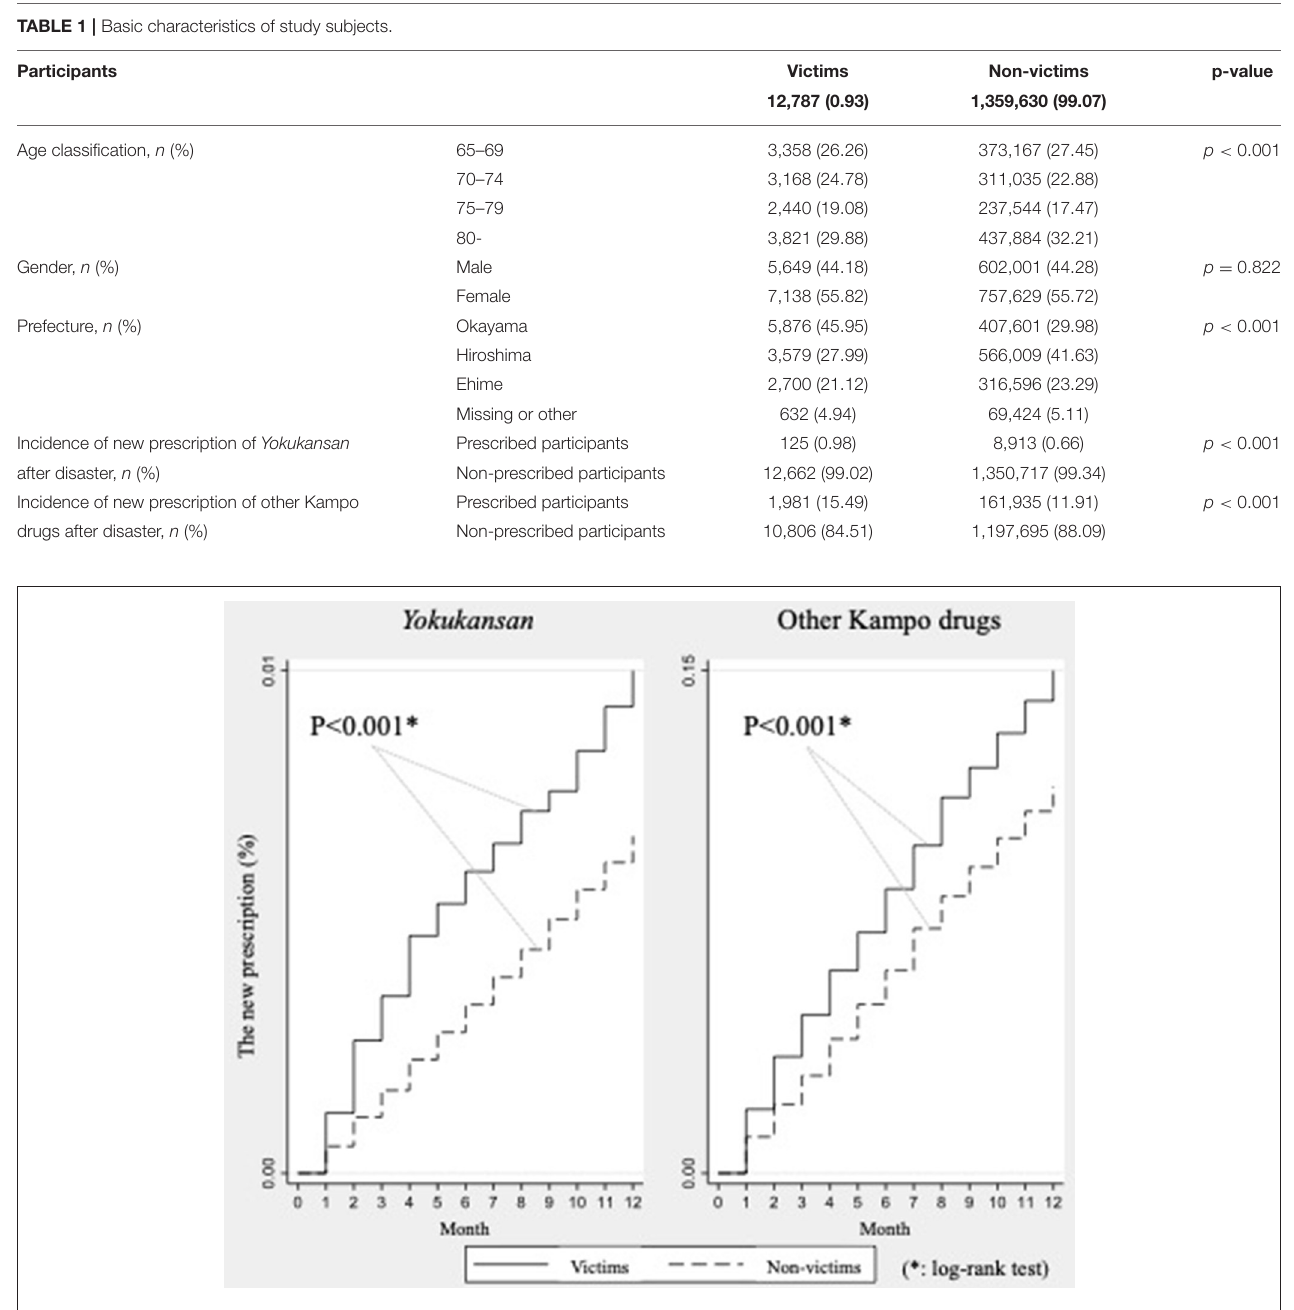
FIGURE 1 | Kaplan-Meier failure curves for the patients of newly prescribed Yokukansan and other Kampo drugs.